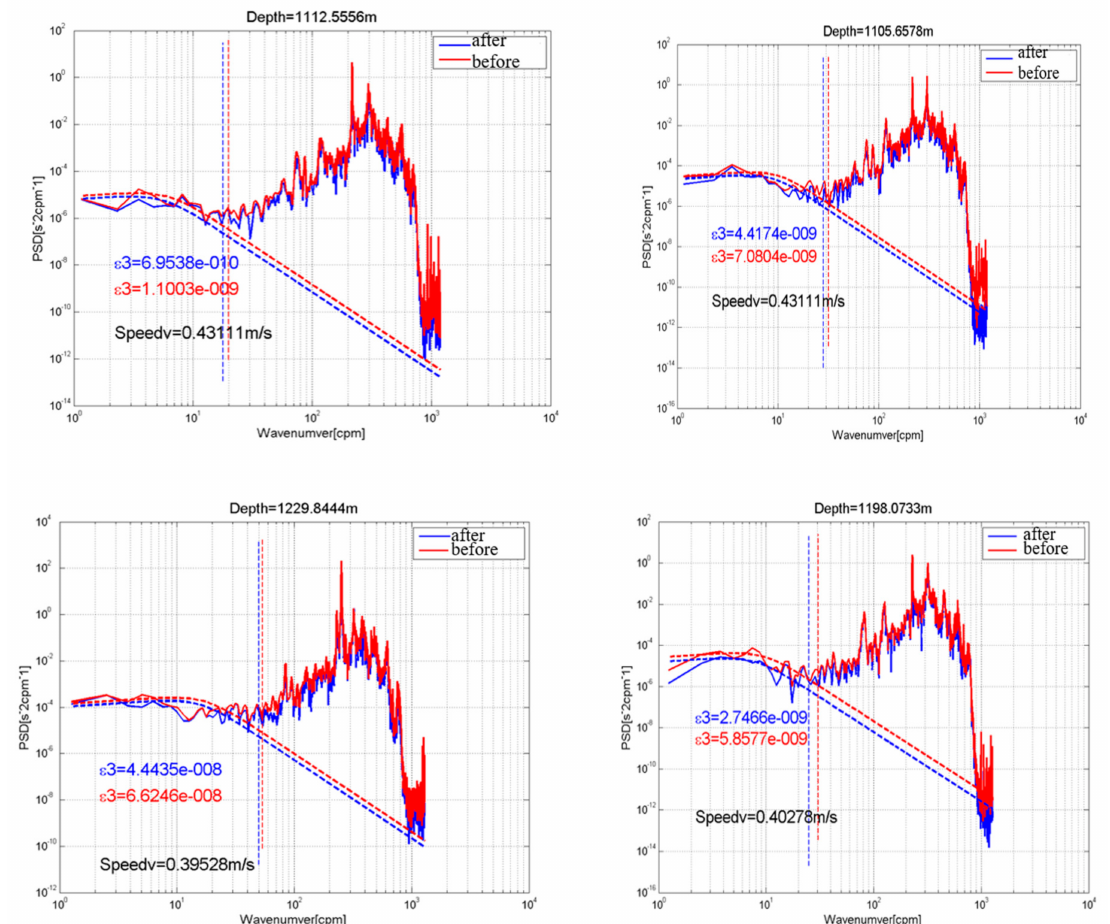
Figure 5. Shear power spectra density (PSD) in wavenumber domain. The red and blue lines denote the raw shear spectra and the cleaned spectra using the cross-spectrum method. The red and blue dashed curves denote the standard Nasmyth spectra, and the two vertical dotted lines denote the Kolmogorov cutoff